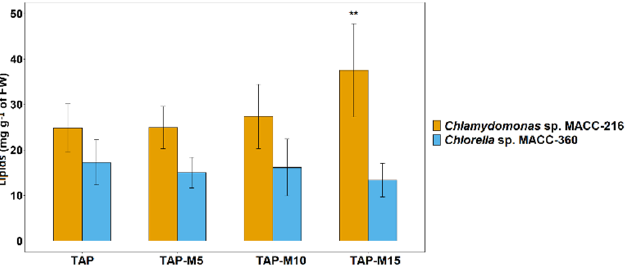
Figure 7. Total lipid contents of Chlamydomonas sp. MACC-216 and Chlorella sp. MACC-360 grown in TAP, TAP-M5, TAP-M10 and TAP-M15. Error bars represent standard deviations; asterisks (**) denote level of significance.